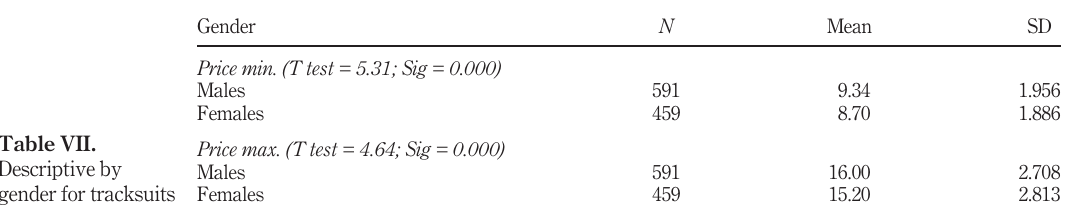
Table VI. Maximum prices for